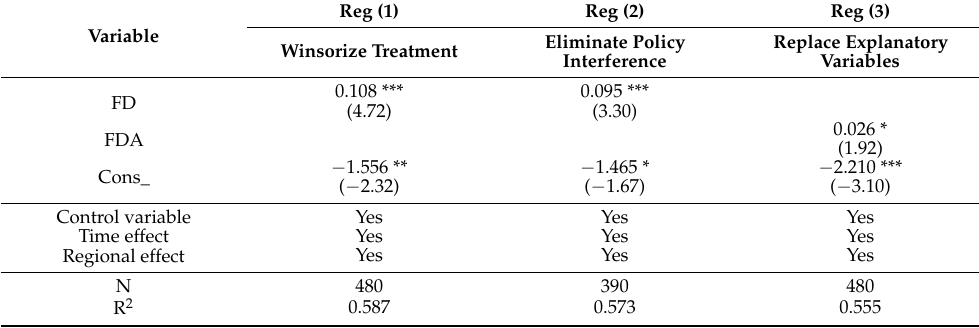
Table 6. Robustness test